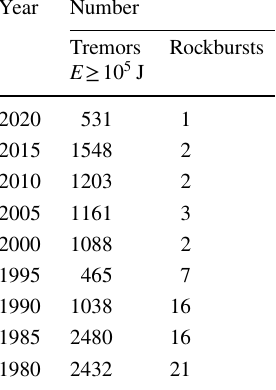
Table 1 Quantitative characteristics of mining- induced tremors and rock